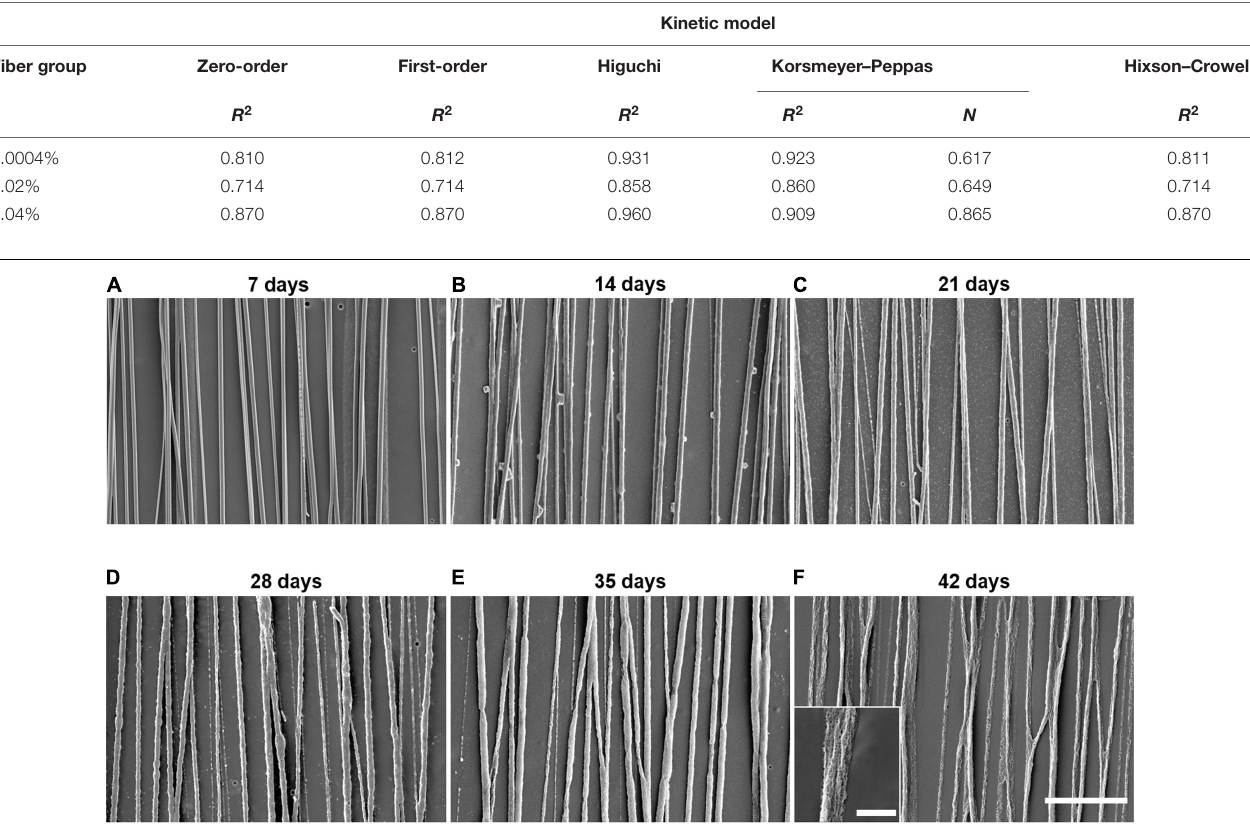
FIGURE 4 | Control poly(lactic-co-glycolic acid) (PLGA) electrospun fibers show significant degradation over 6 weeks. SEM images of control PLGA fibers incubated in cell culture media at 37 ◦ C for (A) 7, (B) 14, (C) 21, (D) 28, (E) 35, or (F) 42 days illustrate the gradual degradation of the fiber scaffolds over 6 weeks. The scale bar of these images represents 20 µ m. The scale bar of the inlaid image represents 4 µ